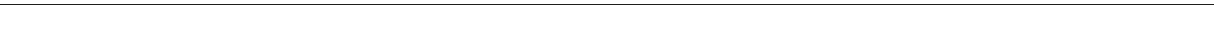
Fig. 5 SAGA complex is essential for DON biosynthesis and virulence in Fg. a Pathogenicity of six gene deletion mutants of the SAGA complex on wheat heads. b Toxisome formation in the hyphae of Δ FgPCN , Δ FgADA3 , and Δ FgGCN5 and wild-type strains under PCN treatment at 15 and 25 µ g ml − 1 . Tri1-GFP was used as the toxisomal marker for observation. The chemical fungicide carbendazim (abbreviated as Car) at the EC90 concentration, 1.4 µ g ml − 1 , was used as a control treatment; bar = 10 µ m. c Expression of Tri1-GFP in tested mutants and the wild type treated with PCN or Carbendazim was veri fi ed by immunoblot assays using the anti-GFP antibody. In addition, the protein samples were also detected with the monoclonal anti-GAPDH antibody as a reference. d Deoxynivalenol (DON) production in the mutants and the wild type treated with PCN or carbendazim. DON in cell-free supernatants after 4 days of incubation in TBI medium were harvested, extracted, and quanti fi ed by LC-MS. Data presented are the mean ± s.d. ( n = 3). e Toxisome formation in the hyphae of Δ FgPCN , Δ FgADA3 , and Δ FgGCN5 mutants and wild-type labeled with Tri1-GFP inoculated on wheat leaf; bar = 40 µ m. f Penetration structures of wild-type, Δ FgPCN , Δ FgADA3, a nd Δ FgGCN5 strains on dissected wheat glumes at 72 h post inoculation. Red arrows indicate the